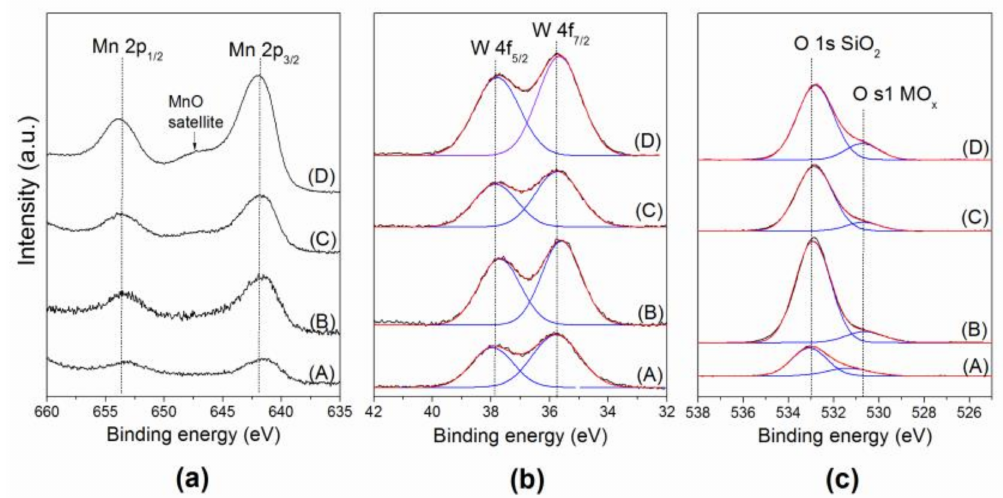
Figure 2. XPS spectra of ( a ) Mn 2p, ( b ) W 4f and ( c ) O 1s level for fresh and used Mn-Na 2 WO 4 /SiO 2